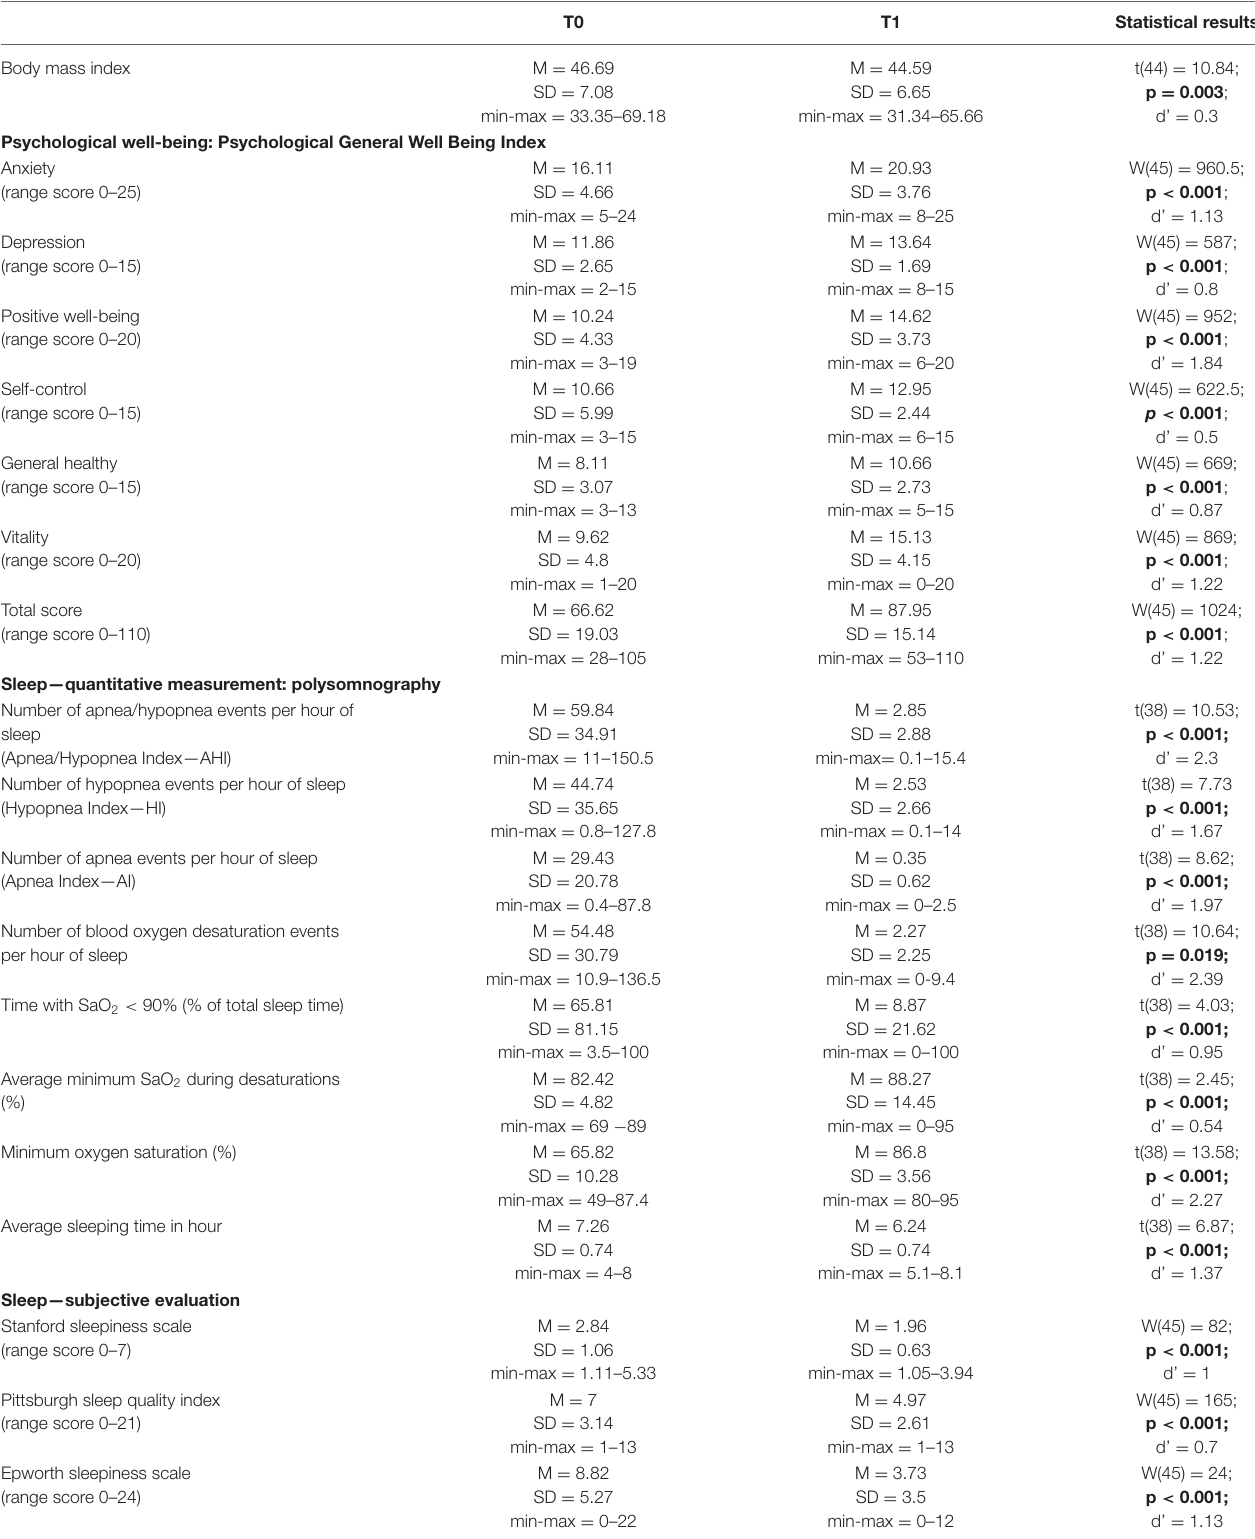
TABLE 2 | Mean, SD, and minimum (min) and maximum (max) for the secondary outcomes measured in this study at T0 (i.e., before the treatment) and T1 (i.e., after the four-week rehabilitation